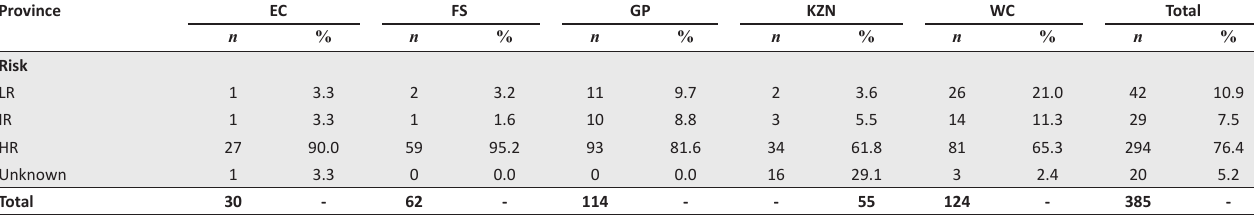
TABLE 5: Neuroblastoma risk stratification at diagnosis from 2000 to 2014 per province in South Africa. Province